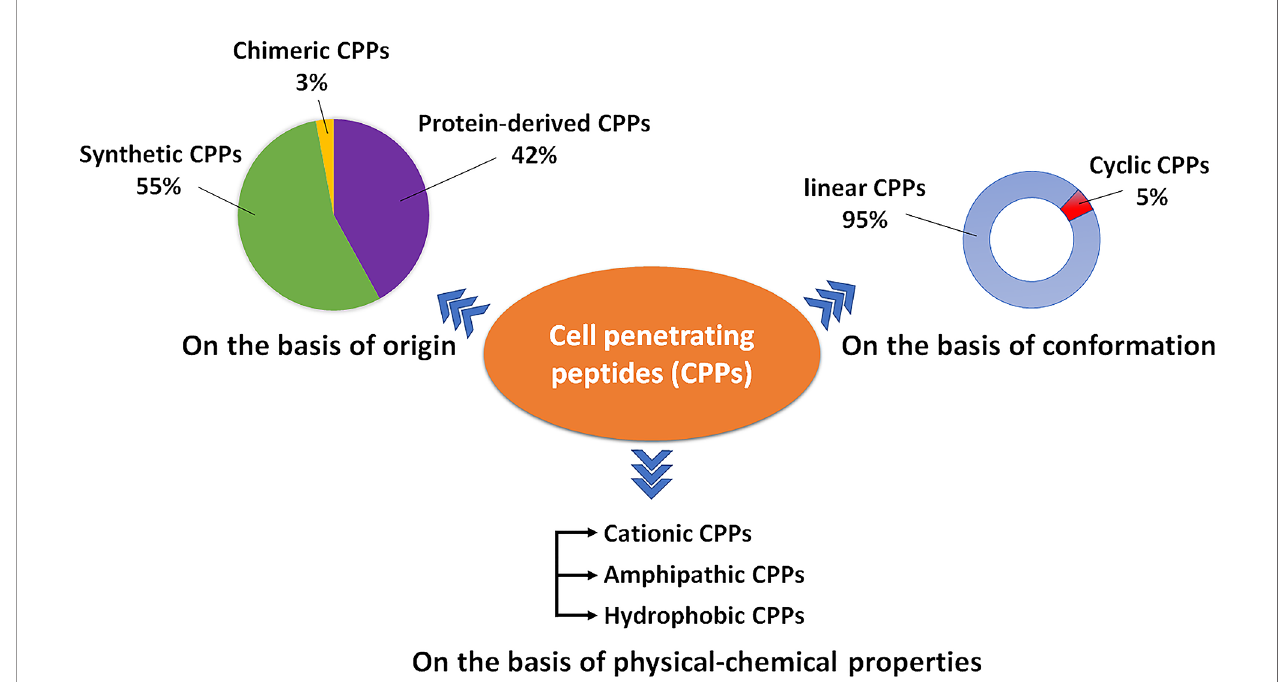
FIGURE 1 | A schematic diagram illustrating the types of